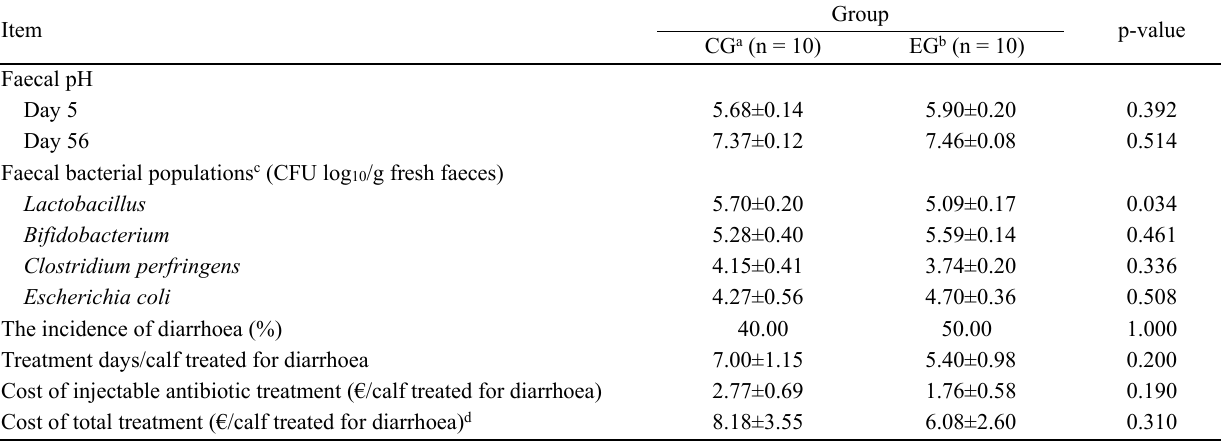
Table 2. Effect of MOS supplementation on faecal pH, faecal bacterial populations, incidence of diarrhoea, treatment days for diarrhoea and the costs associated with diarrhoea treatments in calves